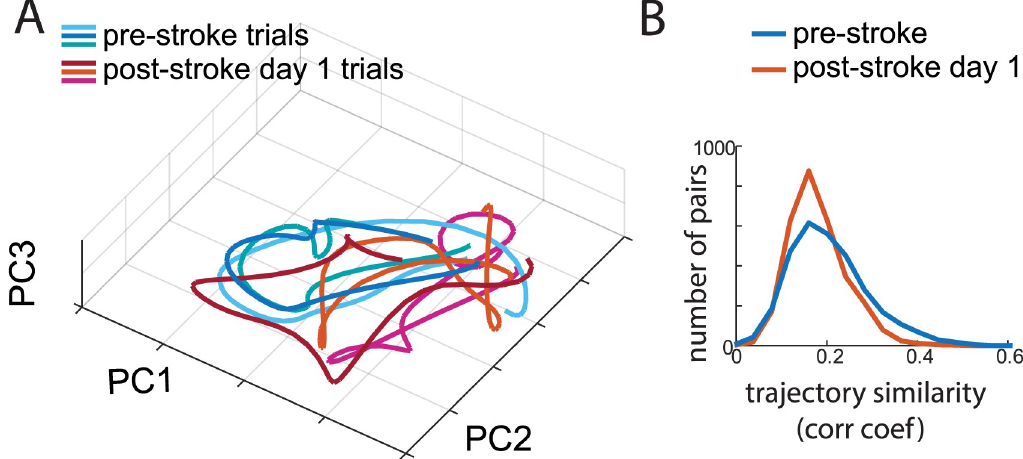
Fig 7. Movement trajectories encoded by the internal network representation are more variable after stroke. (A) Movement trajectories for the three most similar trials before stroke (blue shades) and the three most similar trials after stroke (red shades) for the same rat. Coordinates correspond to the first three PCs of the internal network representation. (B) Distribution of correlation coefficients (“corr coef”) between pairs of trajectories for the day before stroke (blue) and the day after stroke (red). The sample network and data on which this figure is based are available at github.com/hardeepsryait/behaviour_net. PC, principal component.